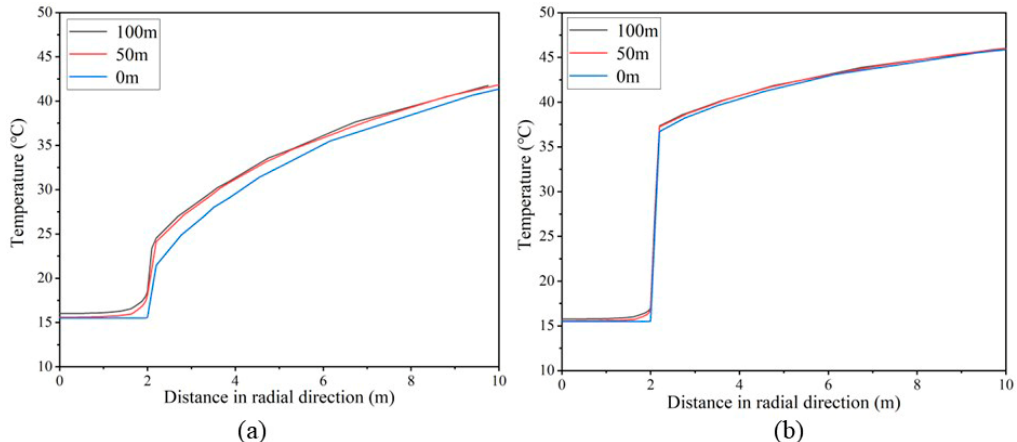
Figure 15. Temperature distribution along the central radial direction: ( a ) Tunnels supported by plain mortar. ( b ) Tunnels supported by insulated mortar.